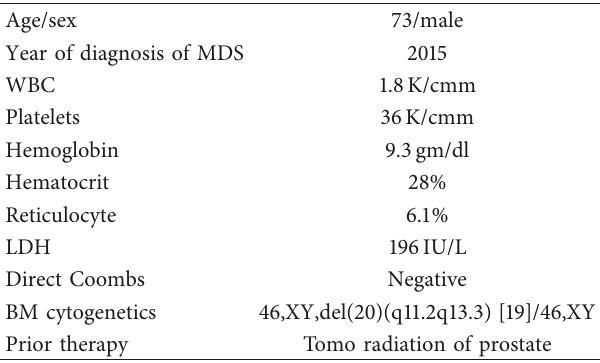
Table 1: Patient’s characteristics.